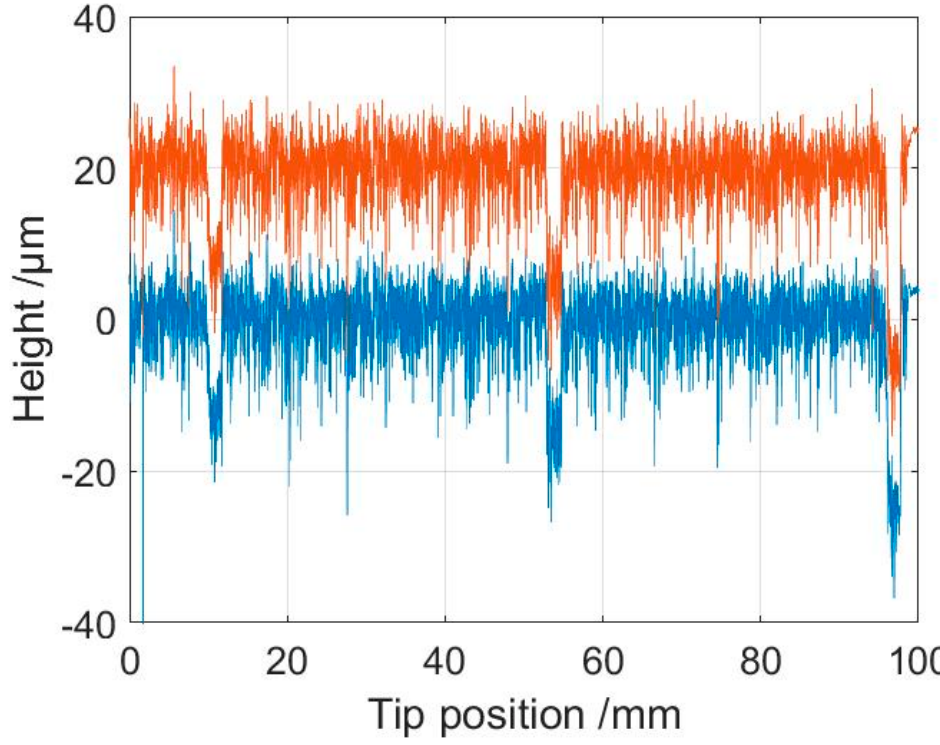
Figure 11. Two consecutive measured profiles of a roll measured at 1.67 mm/s and 100 kHz sampling rate. One profile is shifted by an offset of 20 µm.